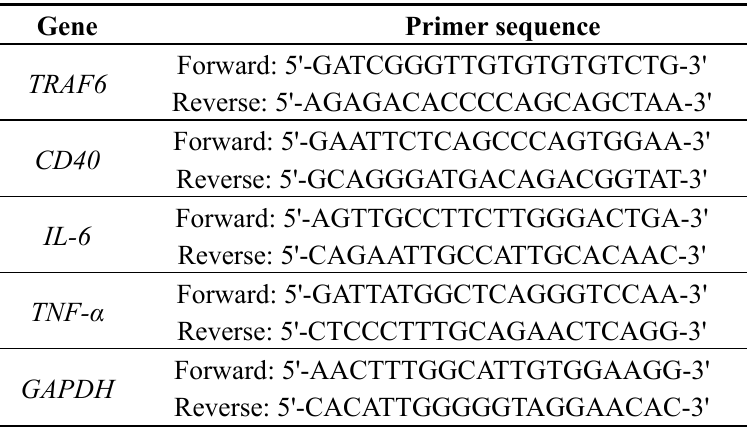
Table 1. Primer sequences for quantitative